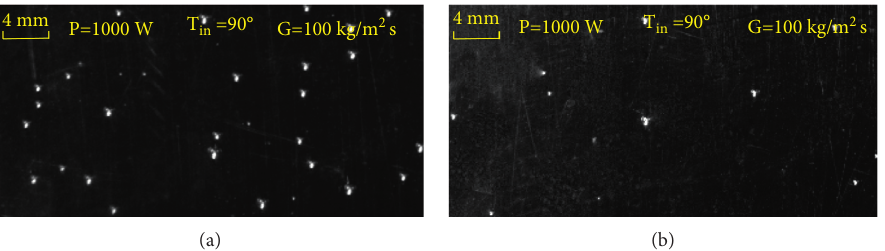
Figure 5: Bubble nucleation sites in channel a and channel b. (a) T 1000W.